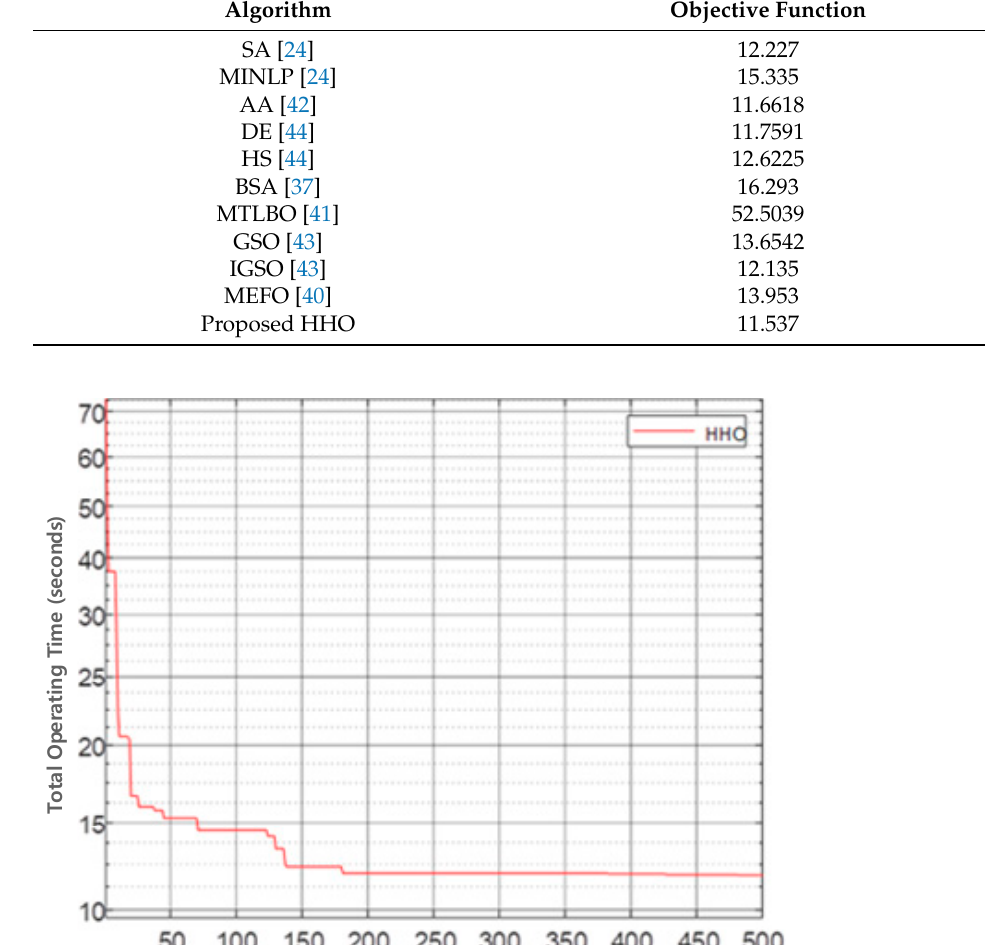
Table 6. Comparison of HHO with other up to Date Algorithms.